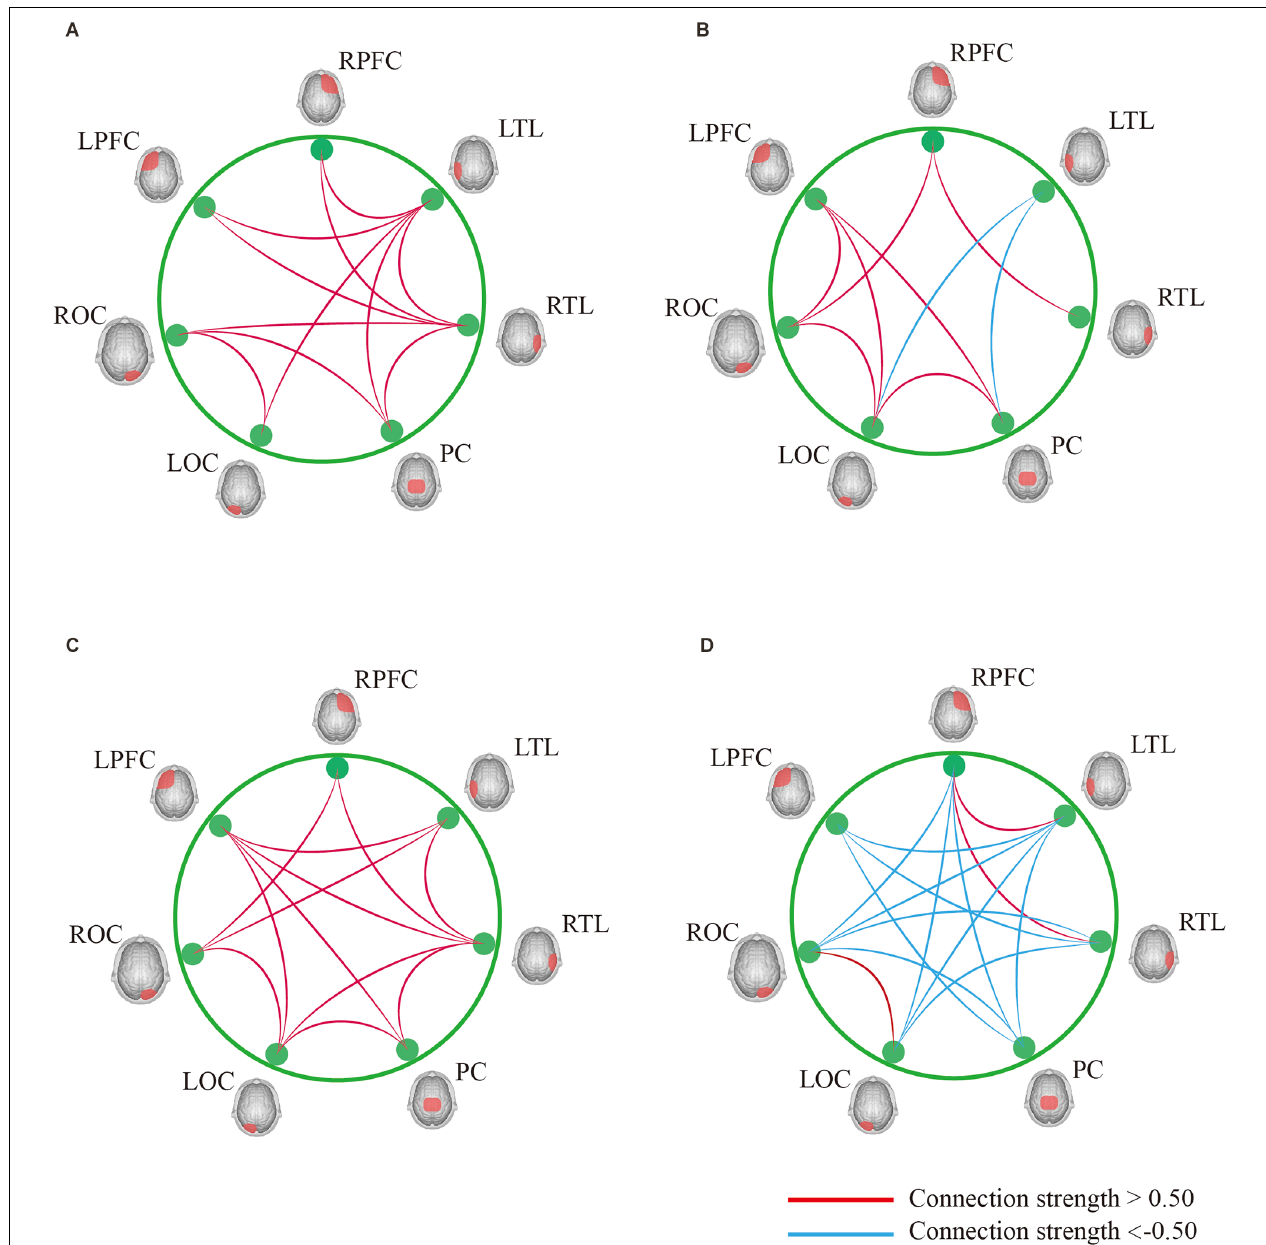
FIGURE 7 | (A) Result of DTW-Easy with Task 1 control group. (B) Result of DTW-Easy with Task 1 cognitive impairment group. (C) Result of DTW-Difficult with Task 1 control group. (D) Result of DTW-Difficult with Task 1 cognitive impairment